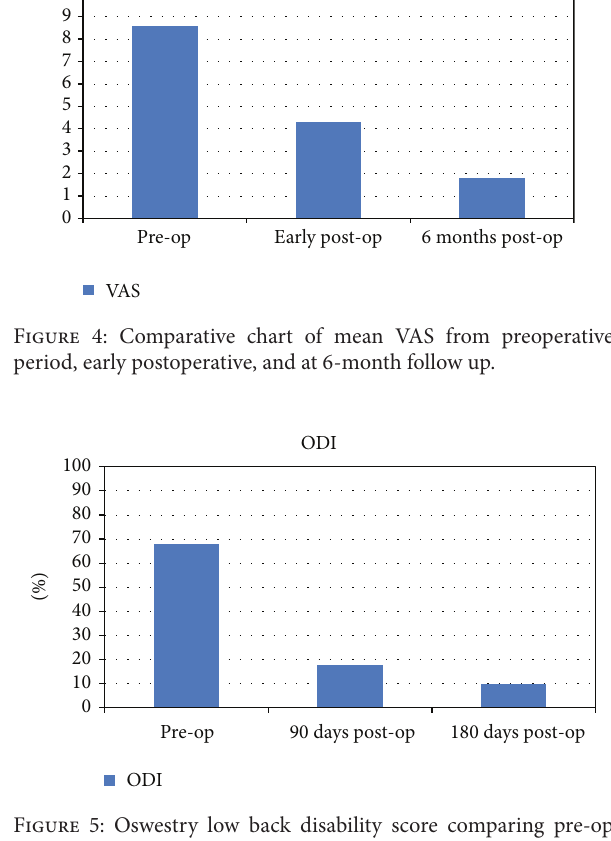
Figure 5: Oswestry low back disability score comparing pre-op evaluation to 3 months and 6 months post-op evaluation.